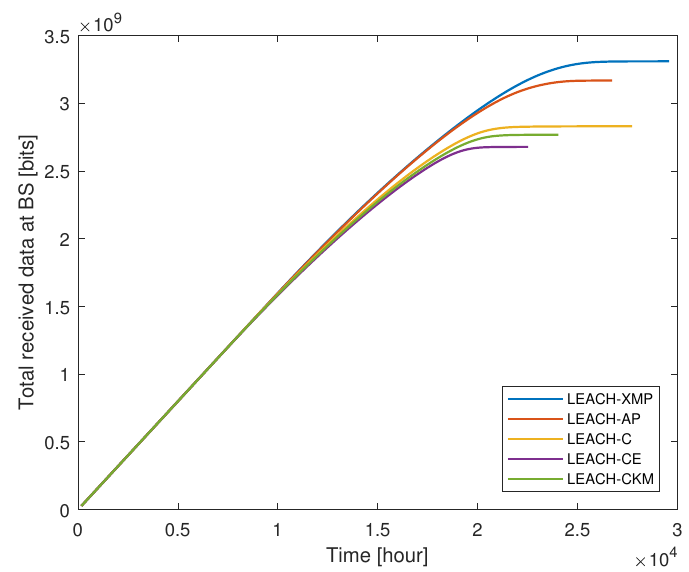
Figure 5. Total amount of data received at the base station (BS) versus time.